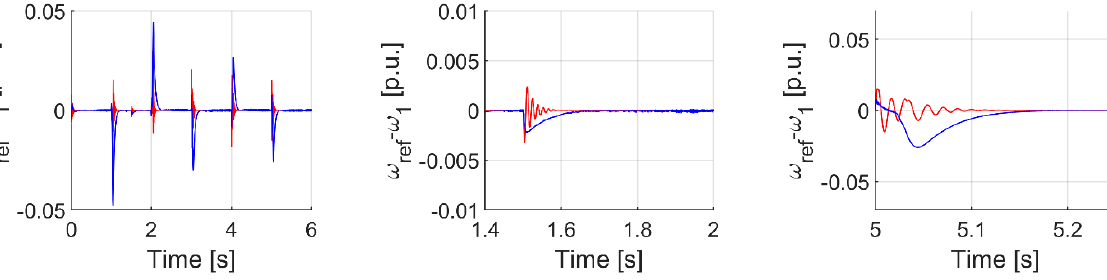
Figure 28. Transients of difference between motor and reference speed for analyzed controller cases.